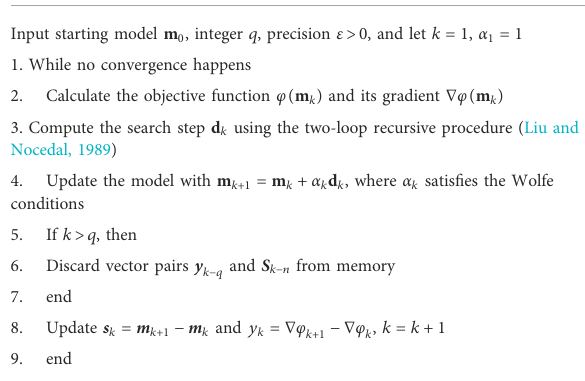
TABLE 1 Outline of L-BFGS algorithm. L-BFGS algorithm for joint MT and ZTEM